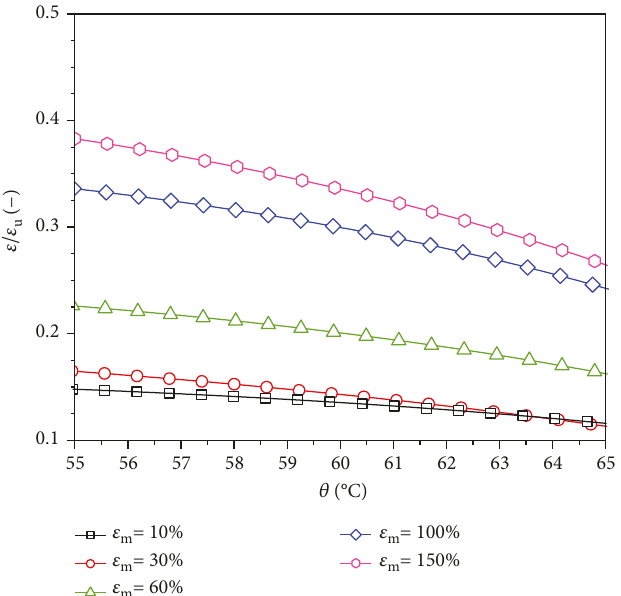
Figure 12: Development of reduced ε values for dry Estane during the recovery process in the 2nd cycle stretched up to di ff erent maximum strains ε (from 10% to 150%) at θ = 70 ° C in a m high cyclic thermomechanical tensile